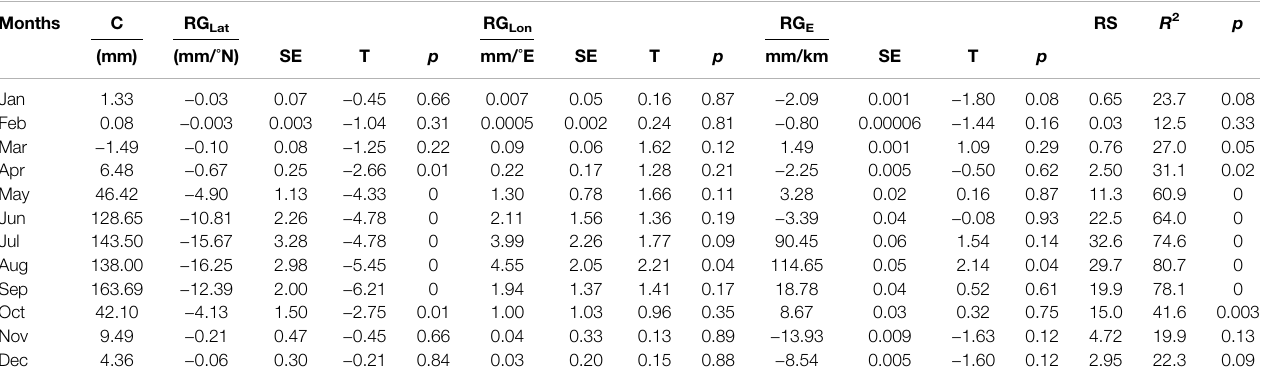
TABLE 4 | Rainfall gradients with elevation and geographical coordinates (latitude and longitude) in the study